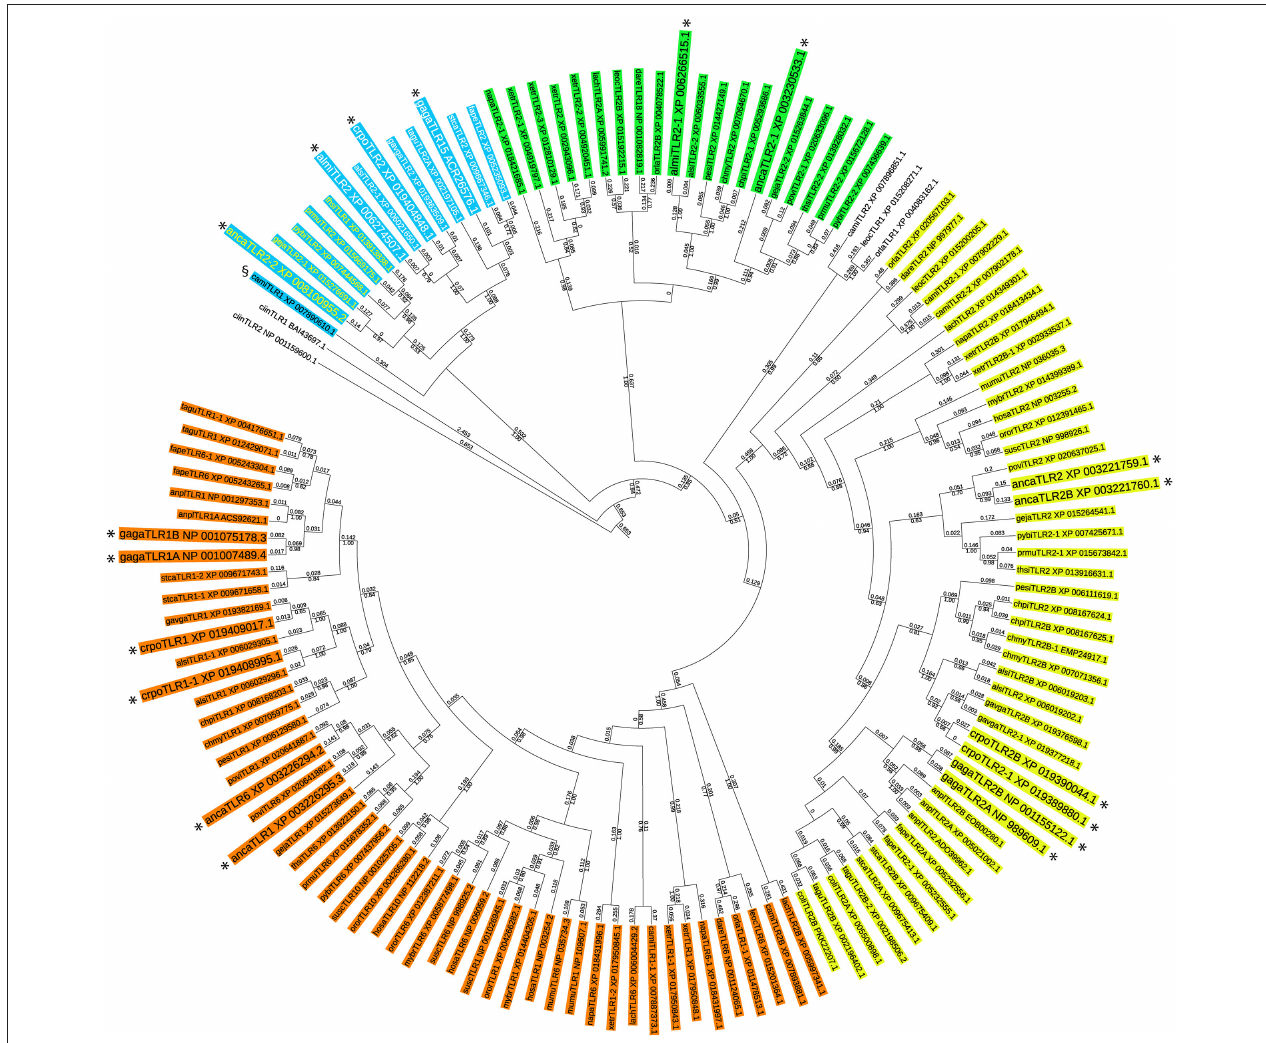
FIGURE 1 | Phylogenetic tree of the vertebrate TLR1 subfamily. The evolutionary history of the vertebrate TLR1 subfamily was inferred by using the Maximum Likelihood method based on the JTT matrix-based model ( 24). The tree with the highest log likelihood ( − 28950.33) is shown. For each TLR sequence the GenBank accession number is indicated. For species abbreviations see Supplementary Table 1 . Bootstrap analysis was performed with 250 iterations and the fraction of trees in which the associated taxa clustered together is shown below the branches (only bootstrap values greater than 0.5 are shown). Branch lengths indicate the number of substitutions per site and are shown above the branches. The analysis involved 136 full length amino acid sequences. All positions containing gaps and missing data were eliminated. There were a total of 252 positions in the final dataset. Evolutionary analyses were conducted in MEGA7 (25). The tree was customized using iTol (26). Four separate groups within the TLR1 subfamily are identified; (i) TLR2 (yellow), (ii) TLR1/6/10 (orange), (iii) a group of TLR2 present only in fish, amphibians, and non-avian reptiles (green), and (iv) the group containing chicken TLR15 (blue). In the TLR15 branch, lepidosaurians are show in yellow letters and archosaurians are shown in white letters. The predicted TLR1 of the ghost shark ( Callorhinchus milii , camiTLR1) is indicated with the § symbol. All TLR1 subfamily members of Anolis carolinensis (anca), Crocodylus porosus (crpo), Alligator mississippiensis (almi), and Gallus gallus (gaga) are shown enlarged and are indicated with an